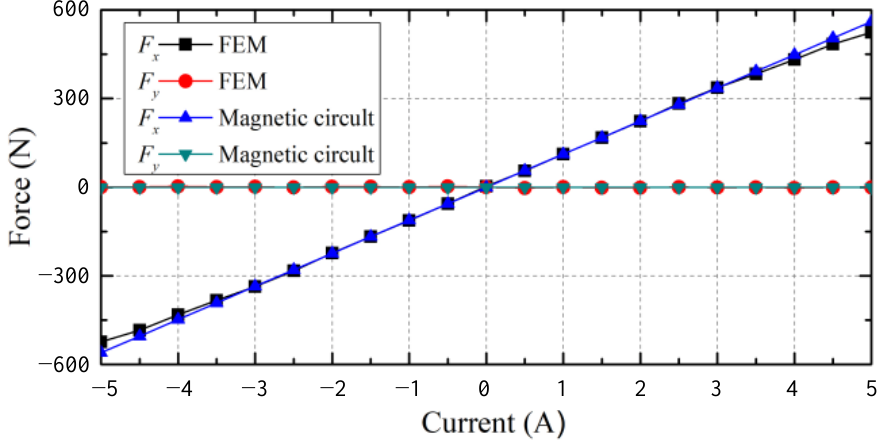
Figure 6. The curves show the correlation between radial suspension forces and radial current.